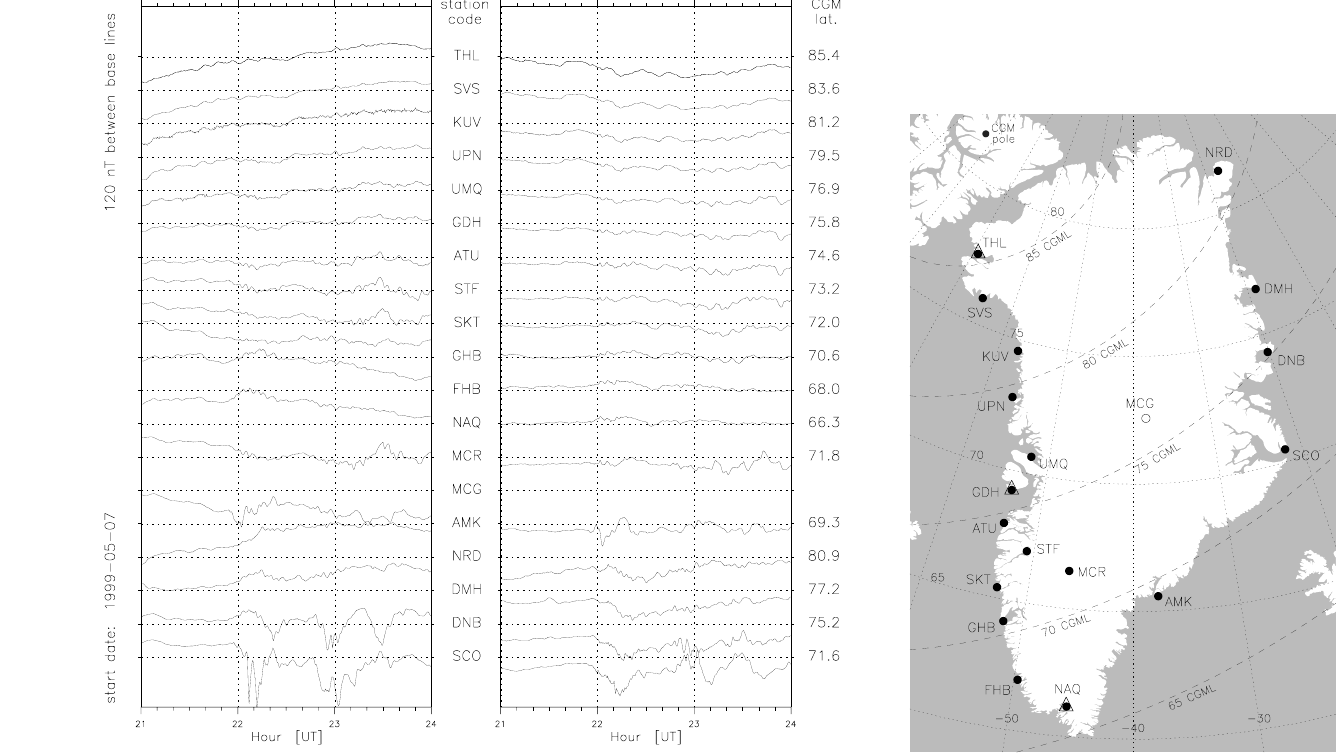
Fig. 3. Greenland magnetometer data given in corrected geomagnetic north and east coordinates for the time period 21–24 UT on 7 May 1999 (a) and a map of the locations of the magnetometer stations (b) .